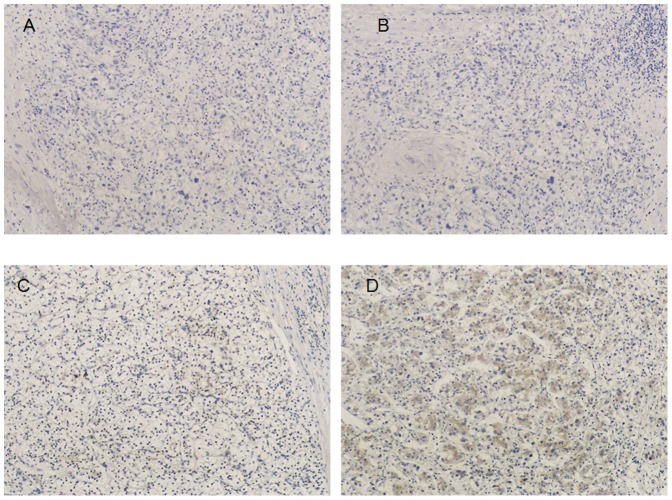
Expressions of Wip1 in human ccRCC tissues and matched non-cancer tissues.(A, B) Negative or low level staining of Wip1 in paired normal tissue and in small part of ccRCC tissues; (C) Moderate staining of Wip1 in tumor tissue; (D)Strong staining in majority of ccRCC tissue; Magnification: 400×.